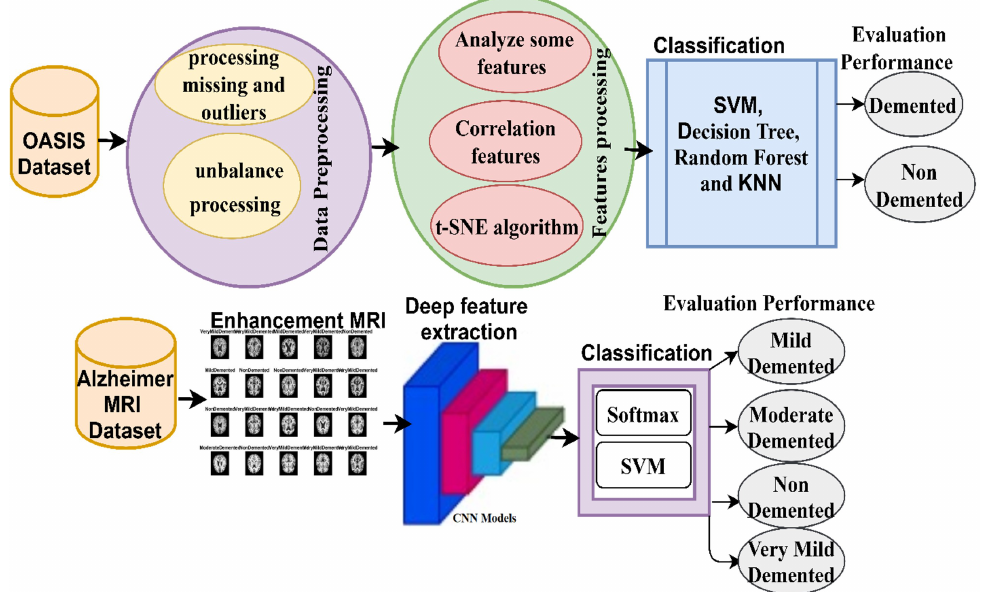
Figure 1. Methodology for classifying the OASIS and MRI Alzheimer’s